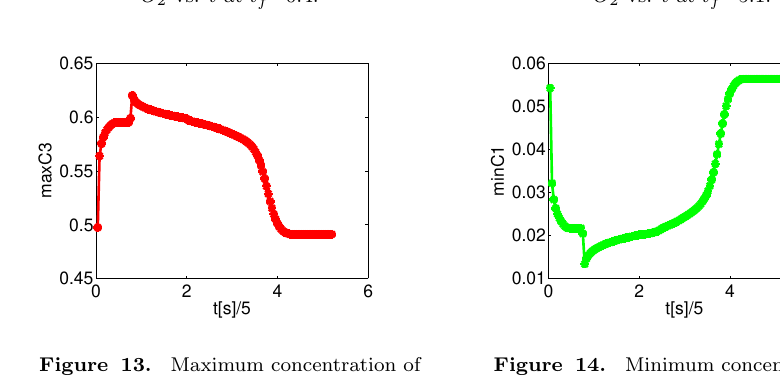
Figure 12. Minimum concentration of O 2 vs. t at t f =5.1.